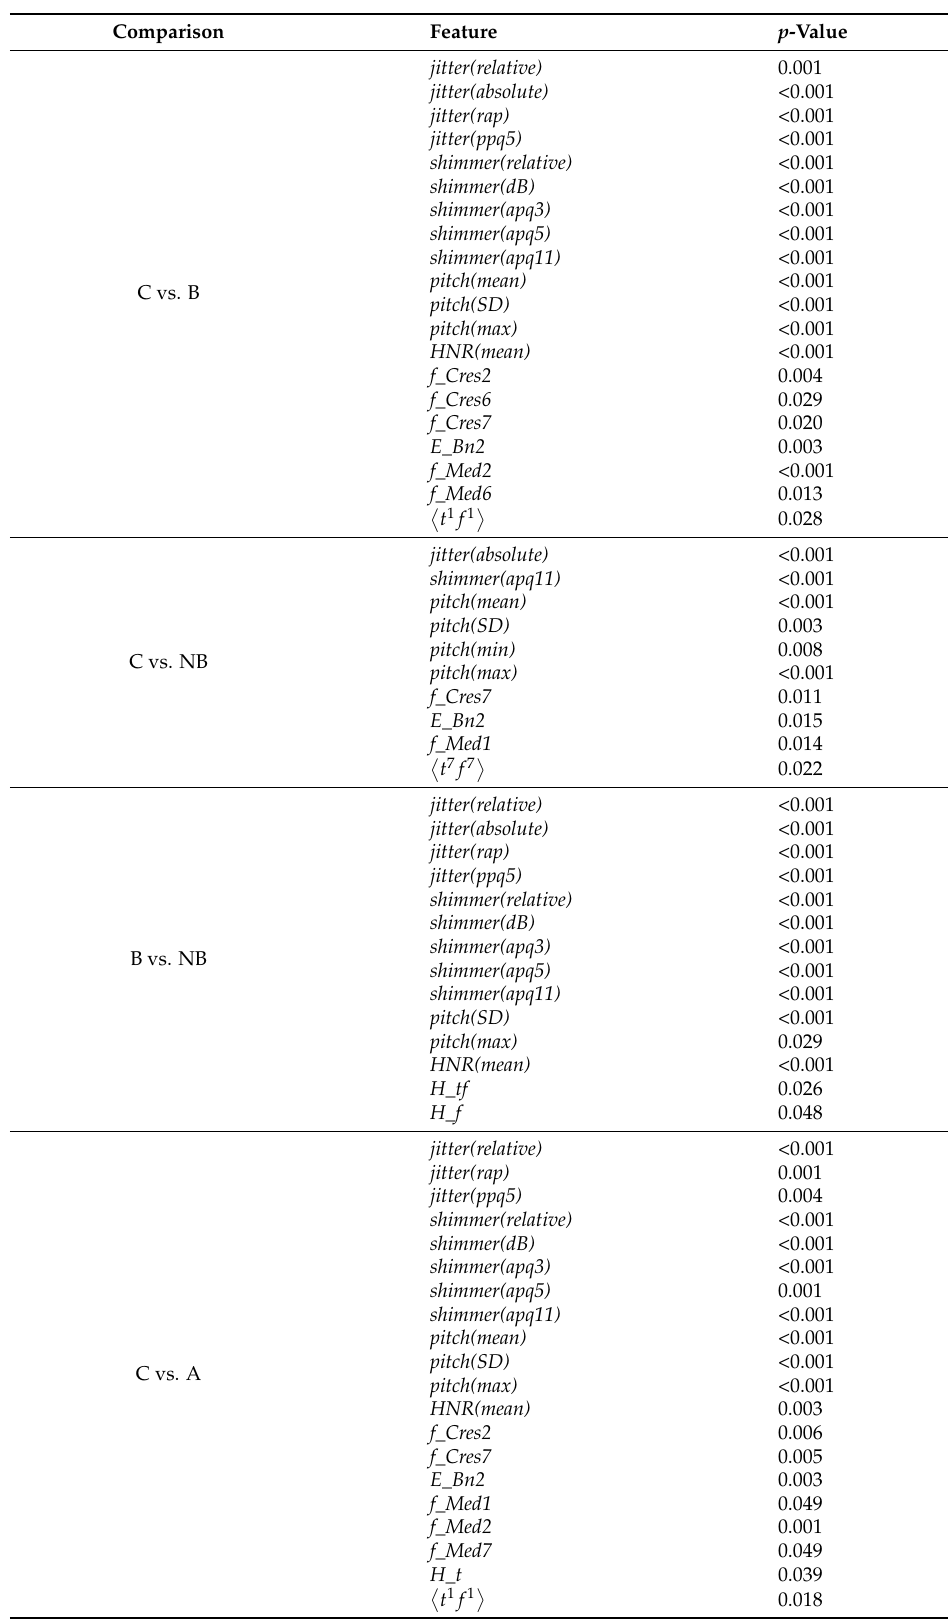
Table 3. Significant Features for